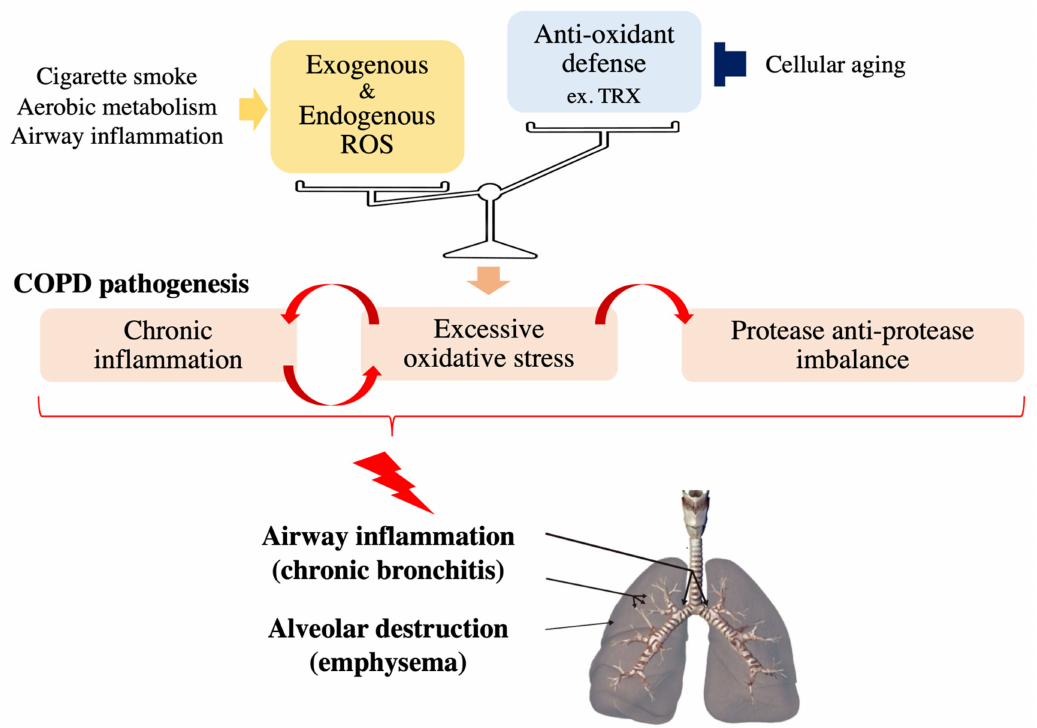
Figure 1. Effects of oxidative stress on COPD pathology. Noxious oxidative stress occurs and contributes to the progression of COPD pathogenesis, such as chronic inflammation and protease anti-protease imbalance, when cellular reactive oxygen species (ROS) levels overwhelm antioxidant